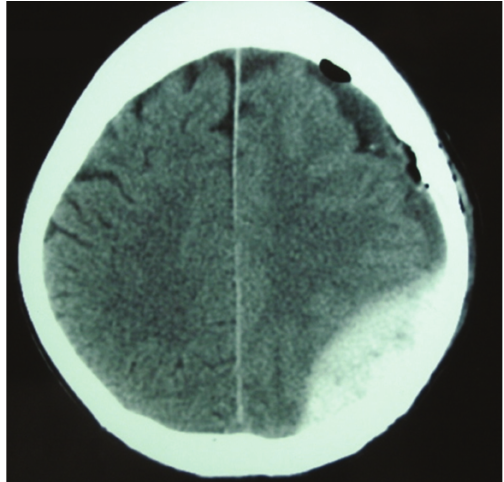
Figure 2: Postoperative CT scan demonstrating a large left parieto- occipital acute epidural